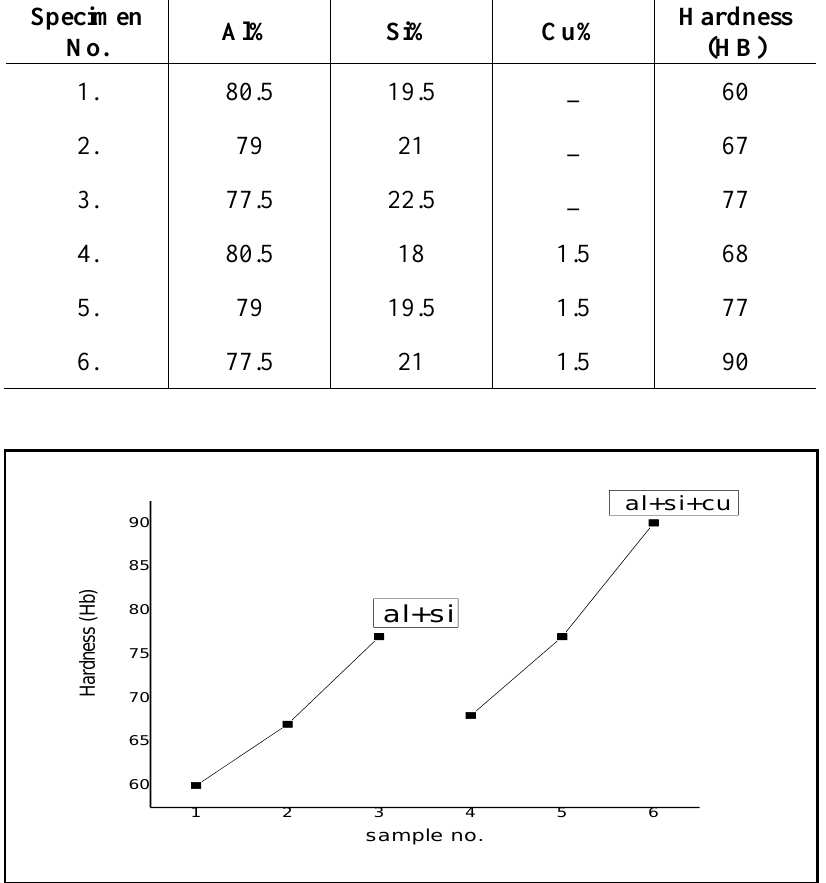
Figure 9: Curve showing variation of Hardness with sample no (Al19.5wt % Si, Al21wt % Si, Al22.5wt % Si, Al18wt % Si+1.5wt % Cu, Al19.5wt % Si +1.5wt % Cu, Al21wt % Si +1.5wt %